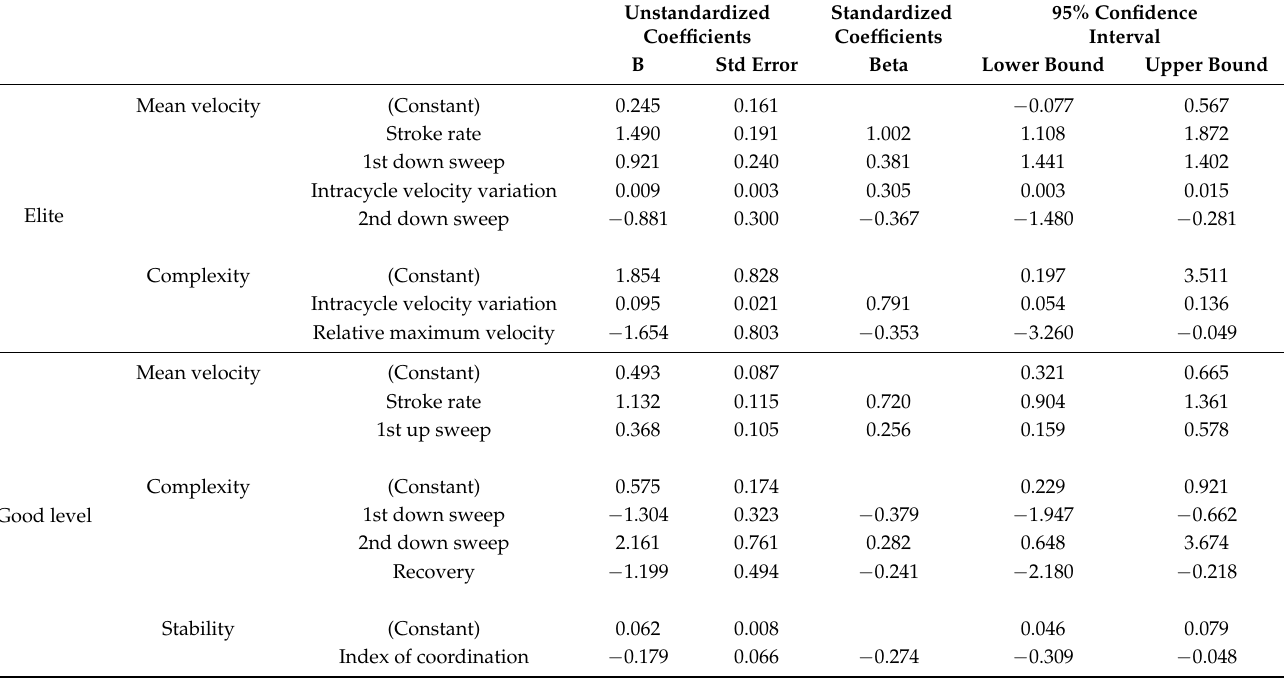
Table 2. Step-wise regression coefficients in elite and good-level swimmers used for predicting mean velocity, complexity, and